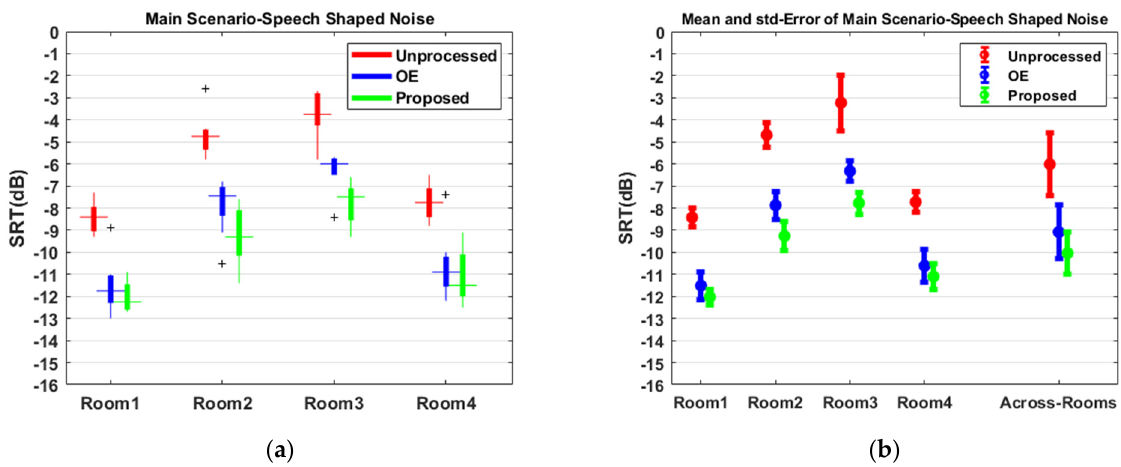
Figure 8. ( a ) Boxplots of speech reception thresholds at 50% speech intelligibility (SRT 50 ) for 8 subjects, measured in the presence of SSN are illustrated. The unprocessed and the preprocessed signals for the main scenarios using the OE and proposed method are compared; ( b ) The mean-SRT 50 and the standard errors for the same data in ( a ) are plotted.